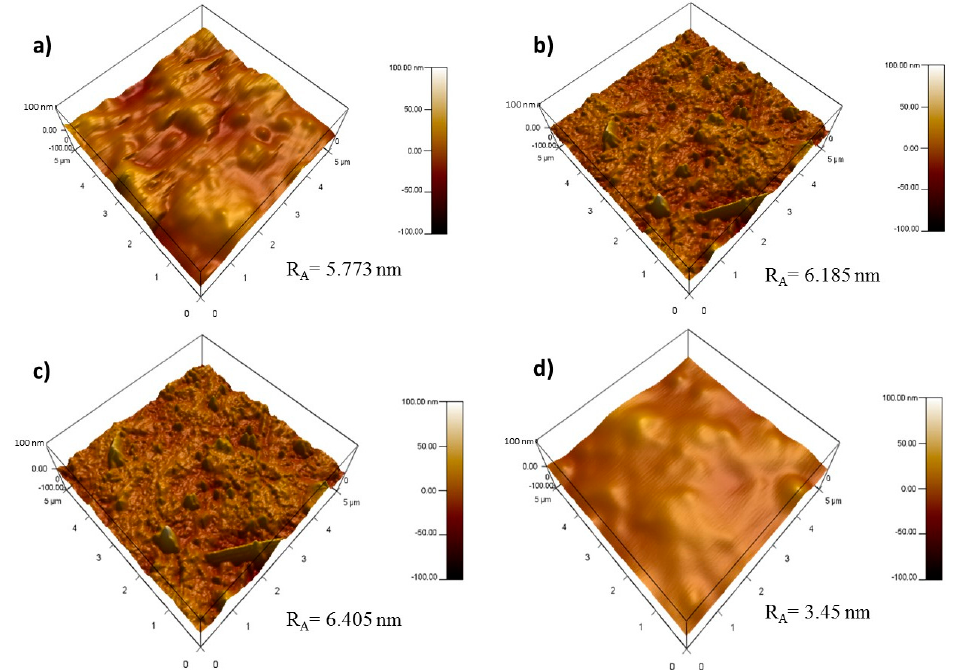
Figure 6. AFM images of surface of: ( a ) PVDF; ( b ) PVDF/rGO; ( c ) PVDF/TNL; and ( d ) PVDF/rGO-TNL.